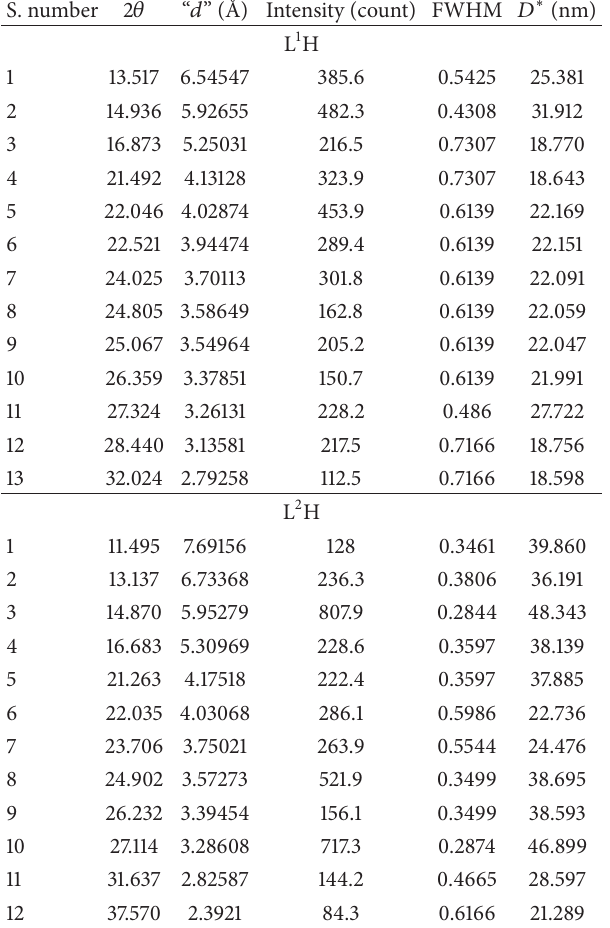
Table 5: X-ray powder diffraction data for compounds (L 1 H) and (L 2 H).